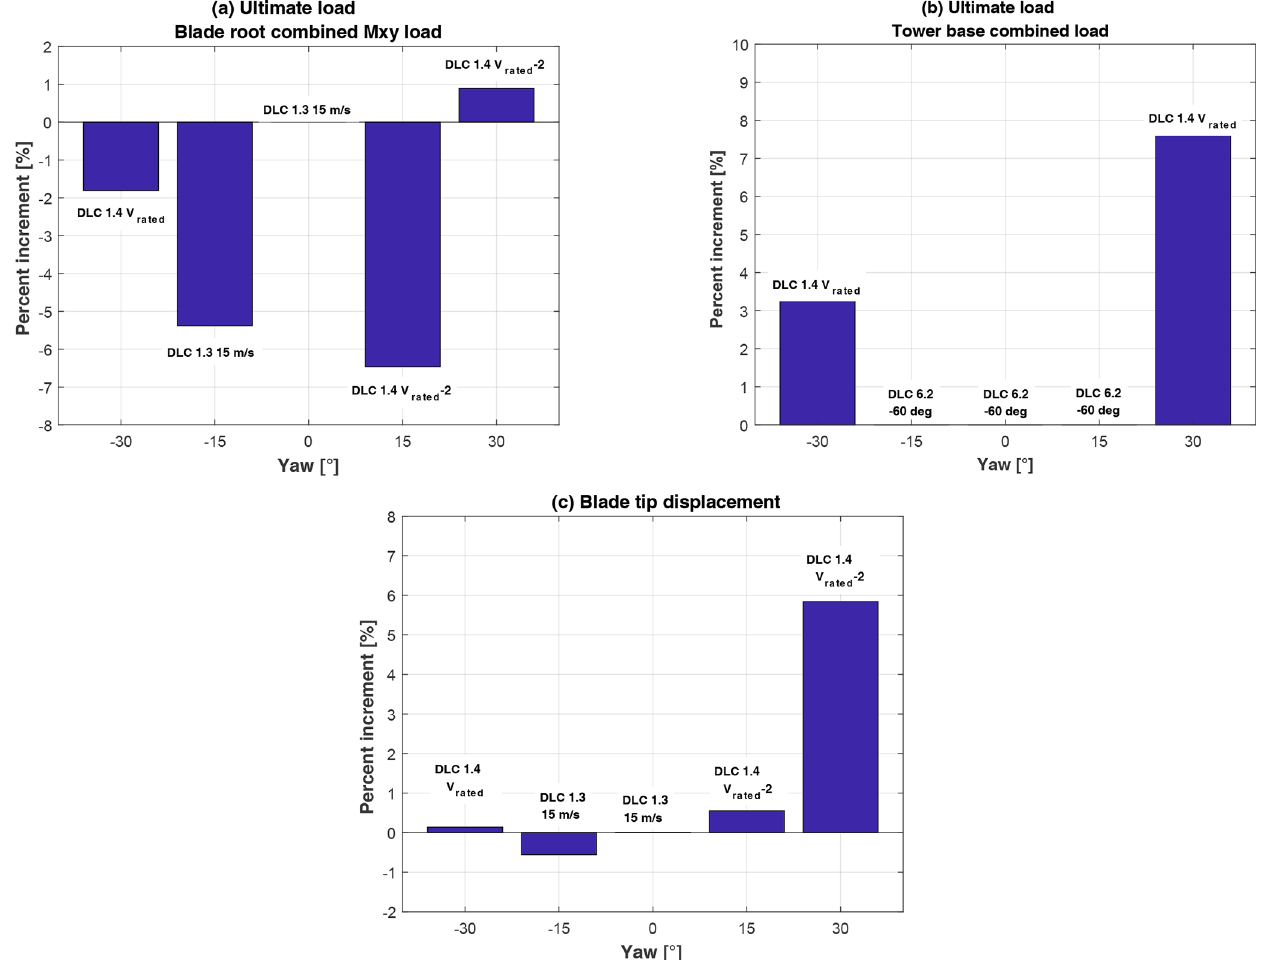
Figure 2. Comparison of ultimate loads and maximum tip deflection. (a) Blade root combined moment. (b) Tower base combined moment. (c) Maximum blade tip